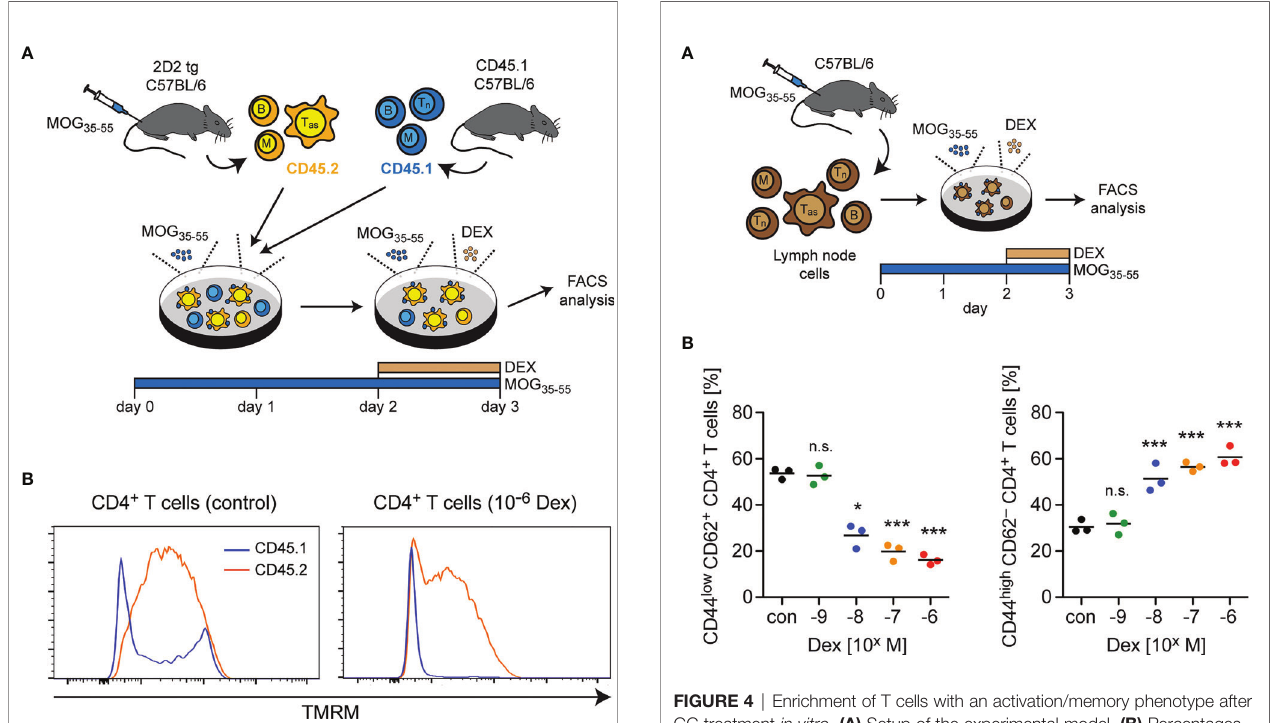
FIGURE 3 | Mitochondrial membrane potential in naïve and antigen-primed effector T cells. (A) Setup of the experimental model. (B) Intracellular stainings of (naïve) CD45.1 + and (antigen-primed) CD45.2 + CD4 + T cells with tetramethylrhodamine methylester (TMRM) after culturing the cells in the absence (control) or presence of 10 -6 M Dex for the last 24 hrs. One representative analysis is depicted for each condition as overlayed histograms. T as , antigen-speci fi c T cells; T n , naïve T cells; B, B cells; M, myeloid cells.